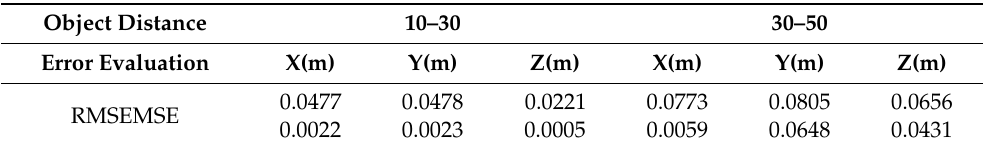
Table 5. Calculated RSME and MAE of position estimation of dynamic Procapra przewalskii with different object distances .